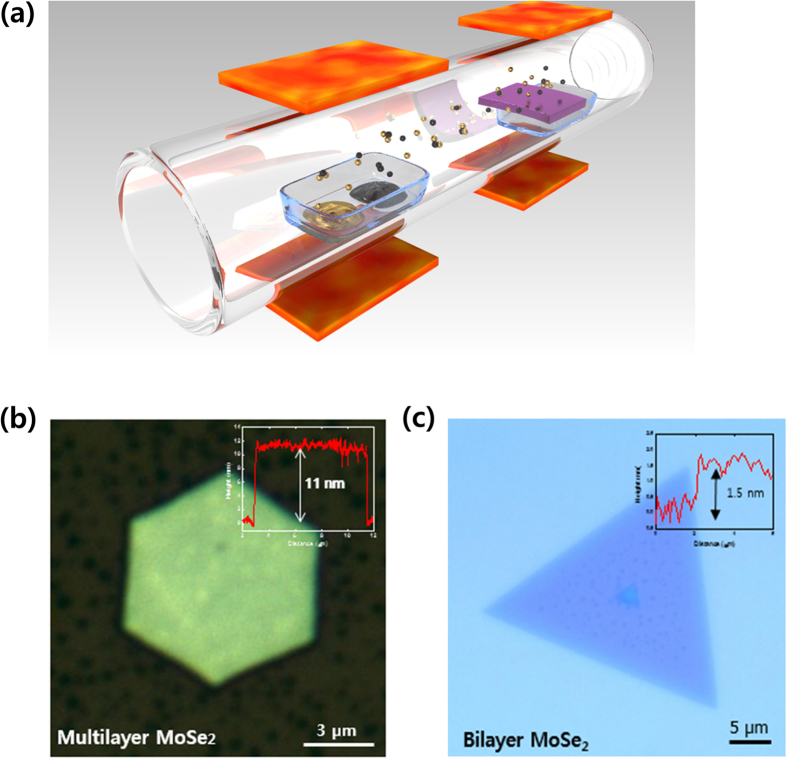
Synthesis of the hexagonal multilayer MoSe2 nanoparticles.(a) Schematic process for the synthesis of the hexagonal multilayer MoSe2 nanoparticles with MoO3 and Se sources. (b) Optical microscope images of the as-grown MoSe2 multilayers and (c) as-grown MoSe2 bilayer on SiO2/Si. The insets show the AFM height profile of the as-grown MoSe2 multilayer and bilayer to measure the thickness.